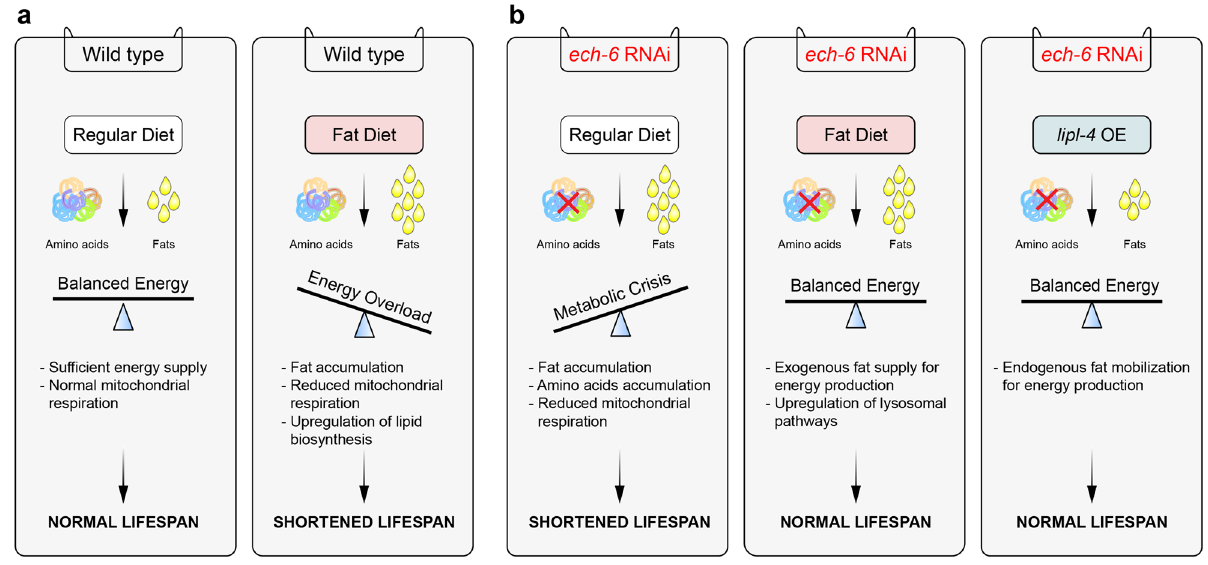
Figure 7. Model for hypothetic interactions between ech-6, lipl-4, a fat diet, and lifespan. ( a ) On a regular diet, worms have sufficient energy supply from mitochondria to maintain a homeostatic balance between energy production and energy consumption. As such, worms display a normal lifespan. However, when worms are exposed to excessive dietary fat, lipid overload disturbs energy homeostasis, suppresses mitochondrial respiration, causes fat accumulation, and ultimately leads to a shortened lifespan. ( b ) Knockdown of ech- 6 engenders metabolic crisis under normal dietary conditions by disrupting branched-chain amino